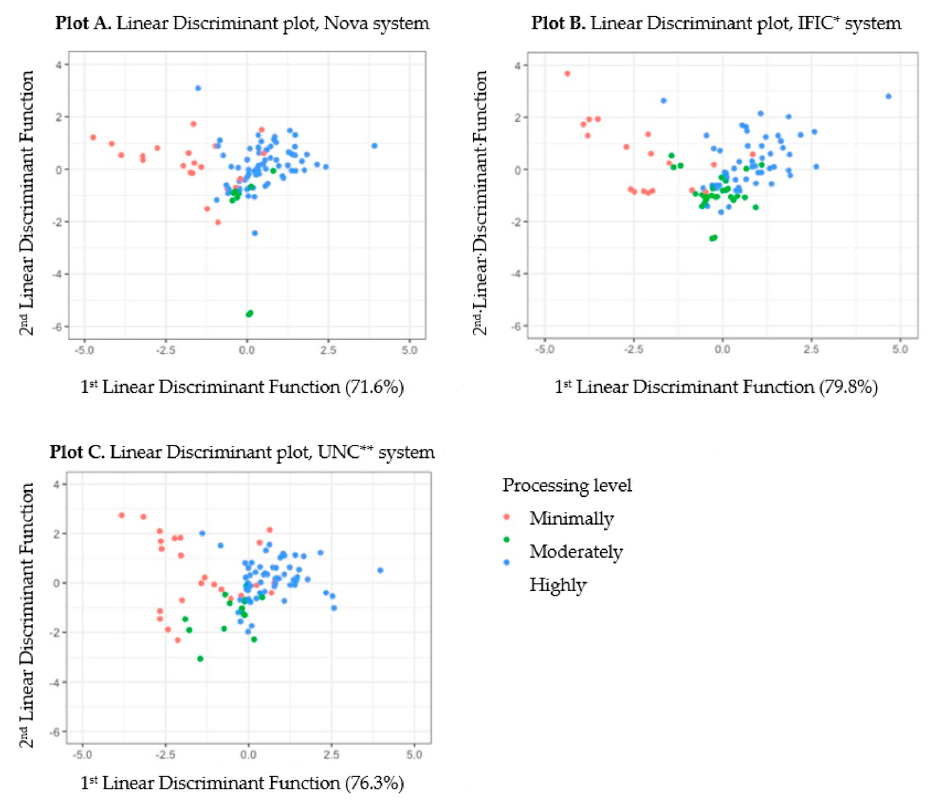
Figure 2. ( A ). Linear Discriminant plot, Nova system. ( B ). Linear Discriminant plot, IFIC * system. ( C ). Linear Discriminant plot, UNC ** system. The top 100 foods consumed by children 6–12 years old (NHANES 2013–2014) by processing category, plotted within the first two linear discriminants for the * International Food Information Council (IFIC), Nova and ** University of North Carolina at Chapel Hill (UNC) systems according to predicted classification category. Percentage of variance explained by